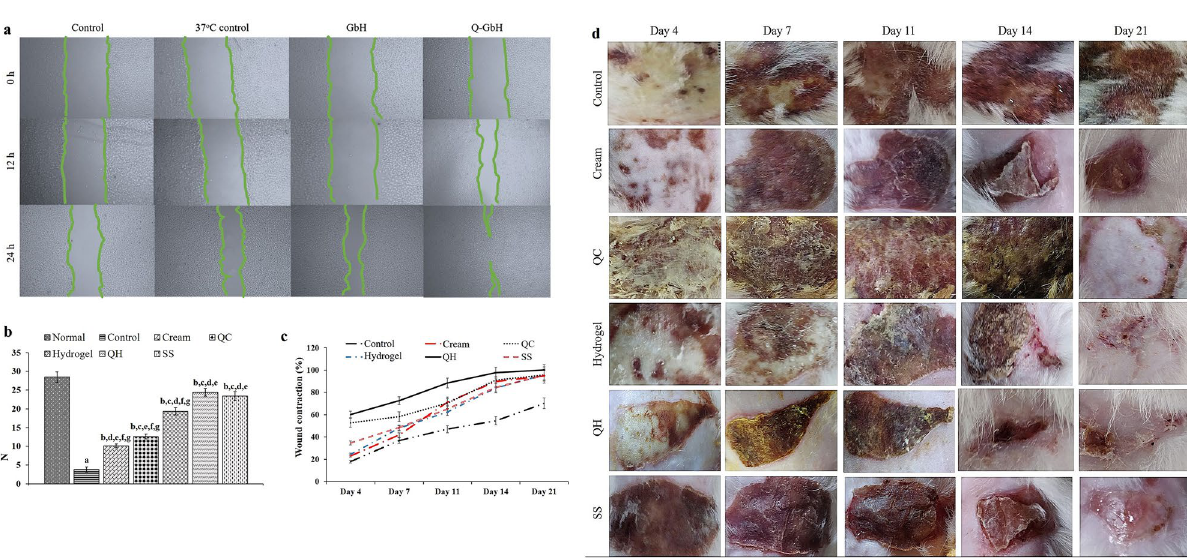
Figure 5. Wound healing performance of GbH: ( a ) Scratch wound healing performance of HaCat cells in 100% replaced of the GbH incubated medium. ( b ) Changes in skin tensile strength in the Normal, Control, cream base group (Cream), quercetin loaded cream (QC), GbH base (Hydrogel), quercetin loaded GbH (QH) and silver sulfadiazine (SS) treated groups. The results are represented as the mean ± S.D. with n = 6 in each group a p < 0.05 as compared to the Normal group; b p < 0.05, as compared to Control group; c p < 0.05, as compared to Cream group, d p < 0.05, as compared to QC group, e p < 0.05, as compared to Hydrogel group, f p < 0.05, as compared